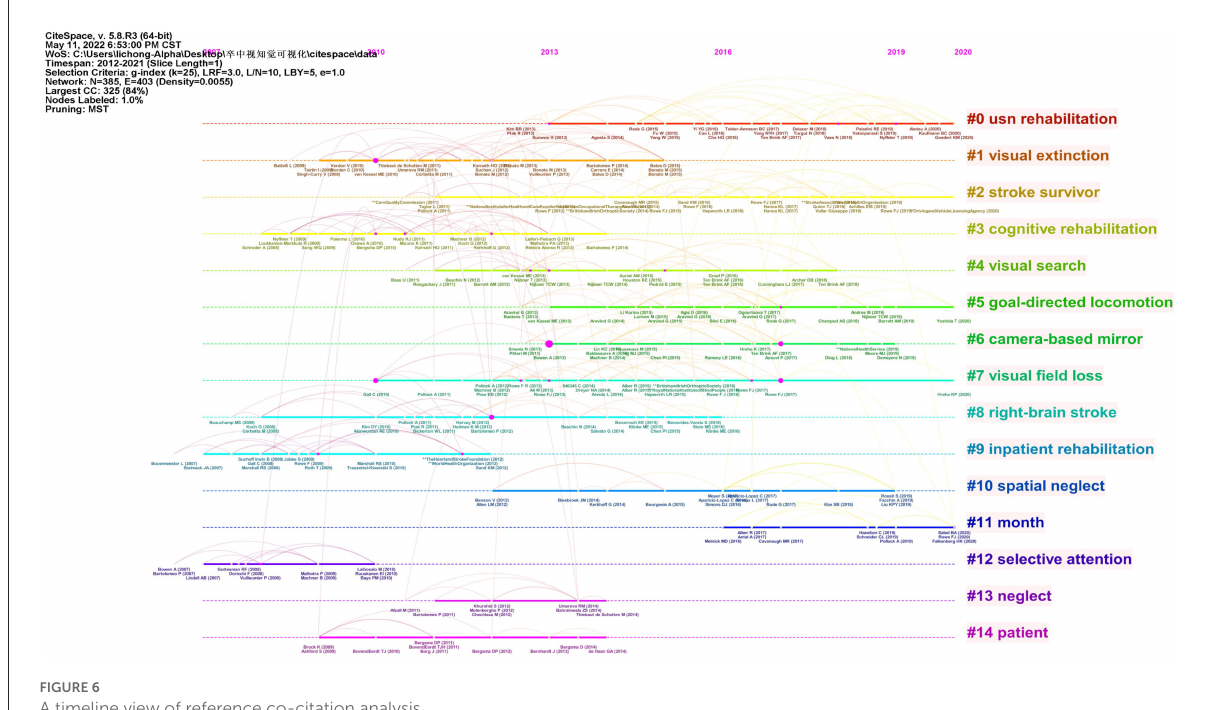
FIGURE6 A timeline view of reference co-citation